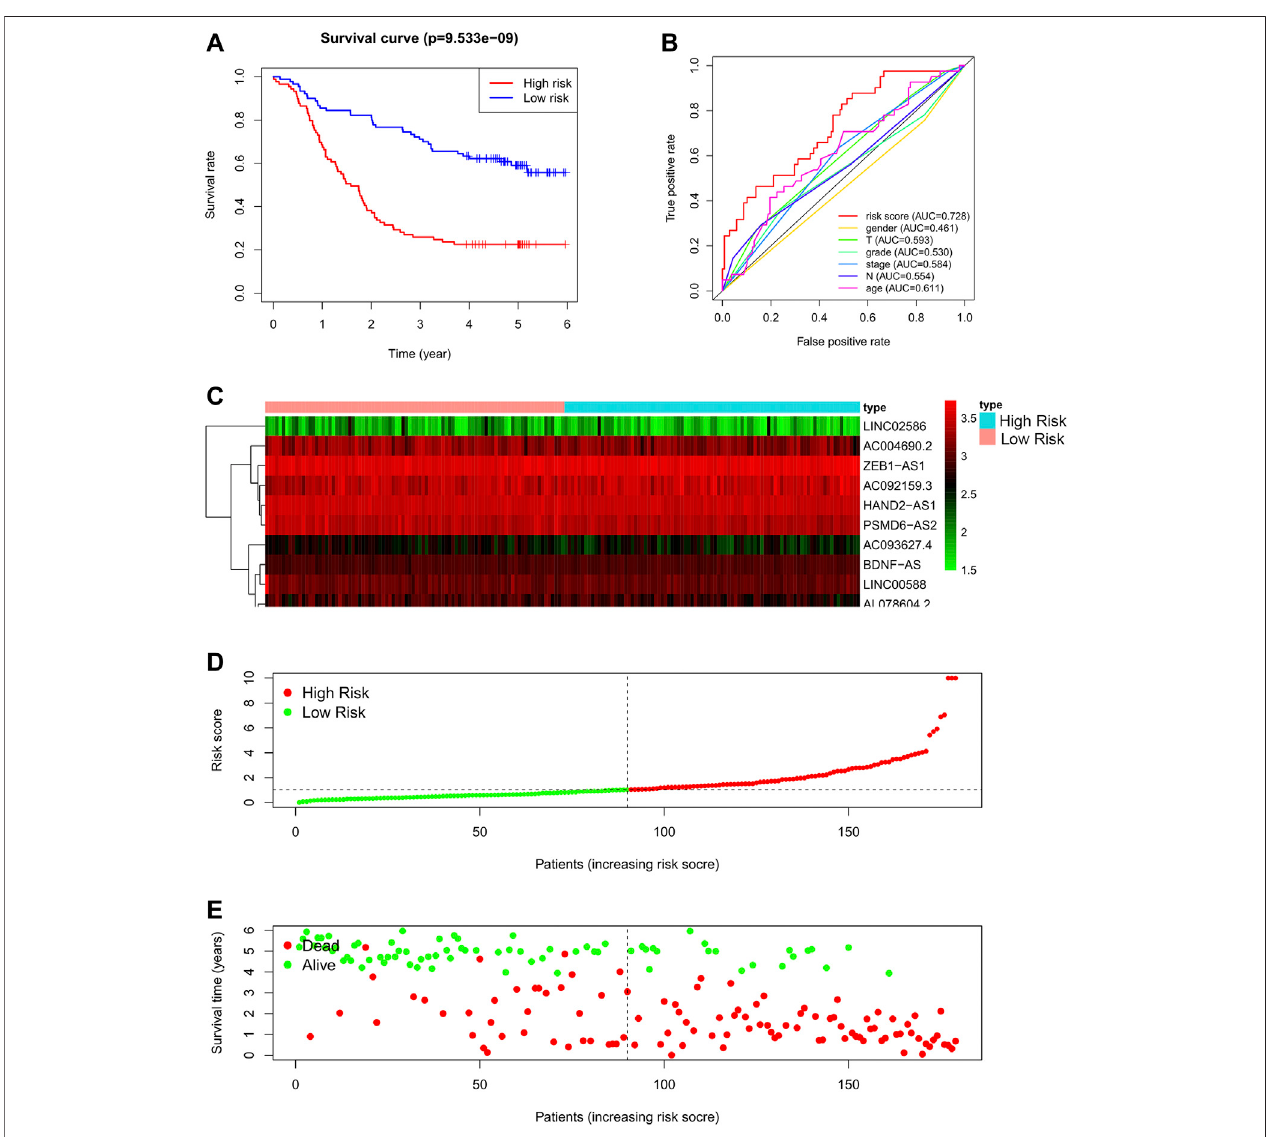
FIGURE 3 | Autophagy related lncRNA risk model in the GSE63625 training set. (A) : Survival curve of ESCC patients based on the risk value, (B) : ROC of the risk modelcompared withotherclinicalcharacteristics, (C) :Expressionheatmapofthe11lncRNAsinpatients, (D) :Patientsdistributionbasedontheriskvalue, (E) :Survival status of all ESCC